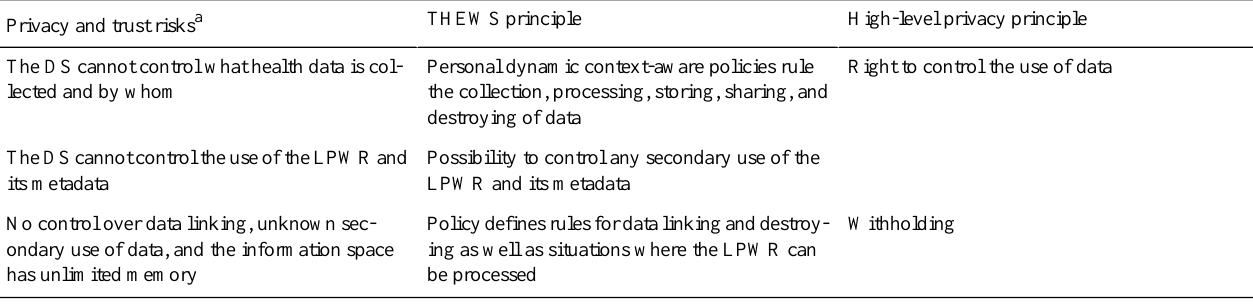
Table 3. Principles of personal policies.